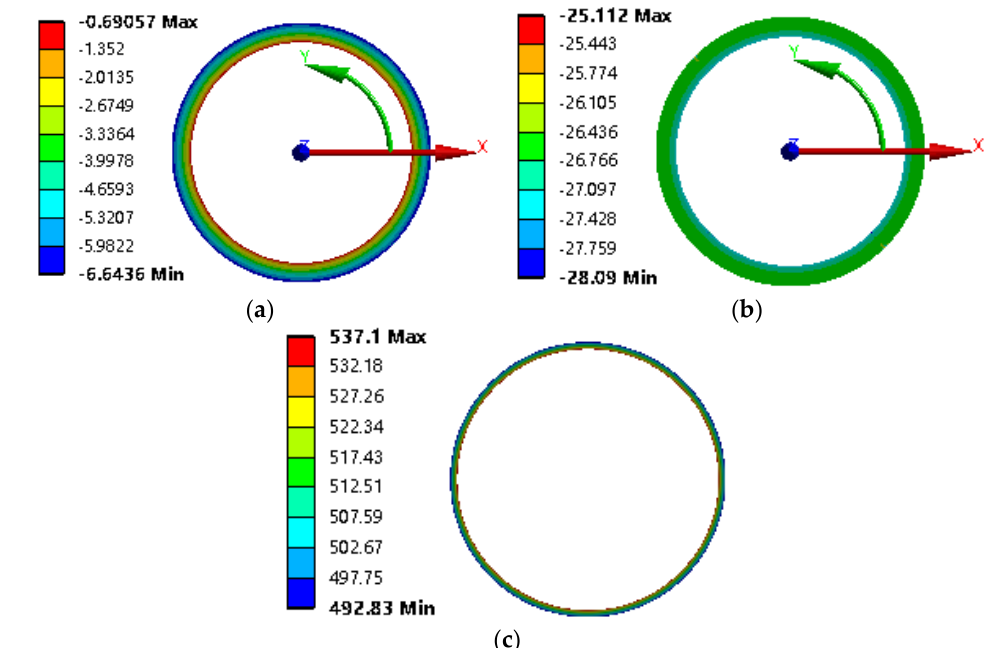
Figure 21. The designed motor’s rotor stress distribution. ( a ) PM radial stress; ( b ) PM tangential stress; ( c ) sleeve equivalent stress.